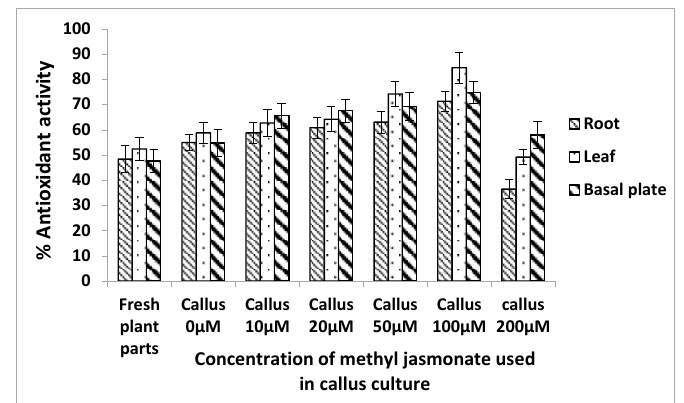
Fig. 2 The effect of methyl jasmonate on total antioxidant in callus cultures of root, leaf, and basal plate tissues of A. cepa . Two-way ANOVA of methyl jasmonate concentration used and calli of plant parts showed significant effects p < 0.05.